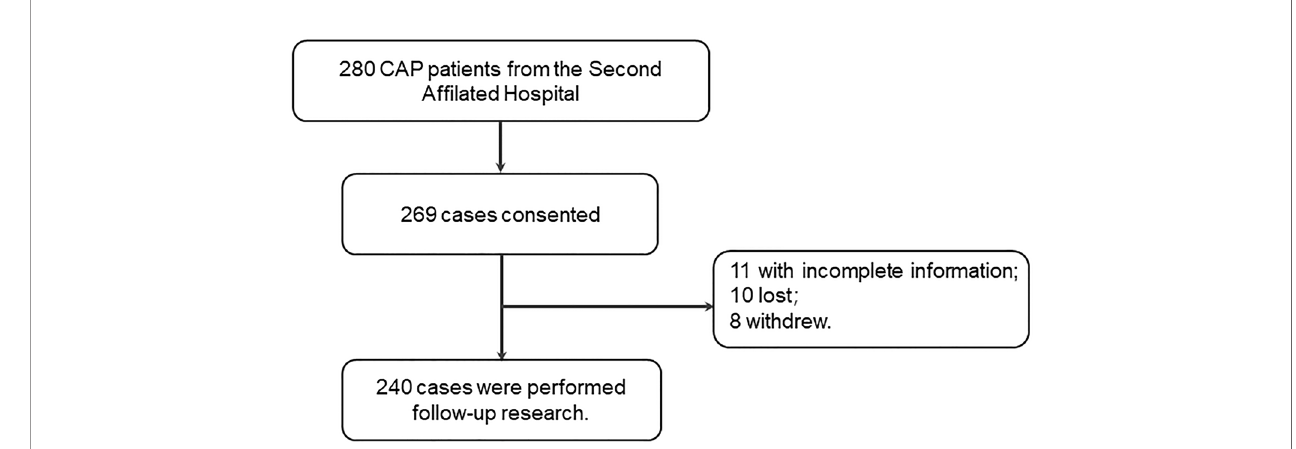
FIGURE 1 | Flow diagram of recruitment and follow-up study in CAP